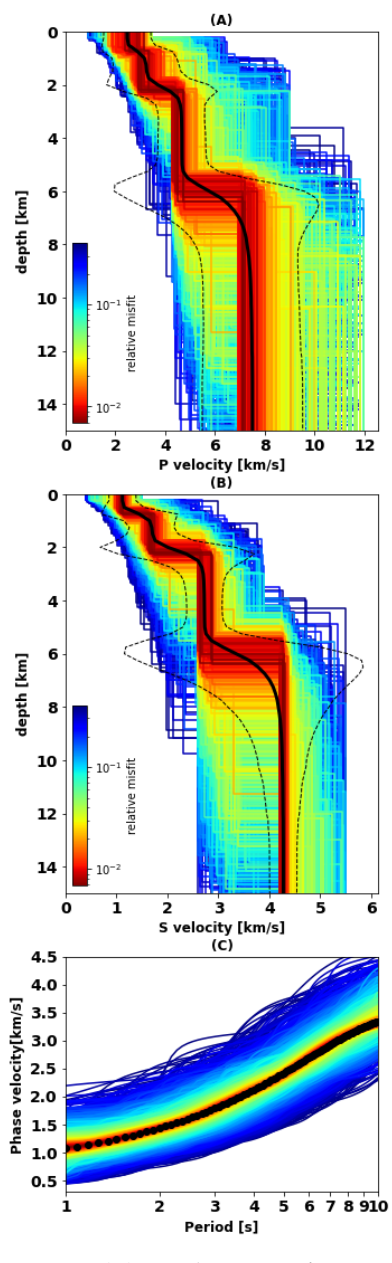
Figure 9. ( A ) 5000 lowest misfit P-wave velocity models, and ( B ) corresponding S-wave velocity model, with color denoting misfit value, as indicated by the color bars. The black solid lines denote the Vp and Vs averages of all shown models. Dashed lines identify our selected confidence interval, which we define as three standard deviations above and below the average, at each depth. Bulges in the dashed lines around discontinuities are inevitable artifacts of combining uncertainty in seismic velocity and discontinuity depth. ( C ) Rayleigh phase-velocity data corresponding to the models in ( A , B ). The black curve in panel ( C ) identifies the picked values of phase